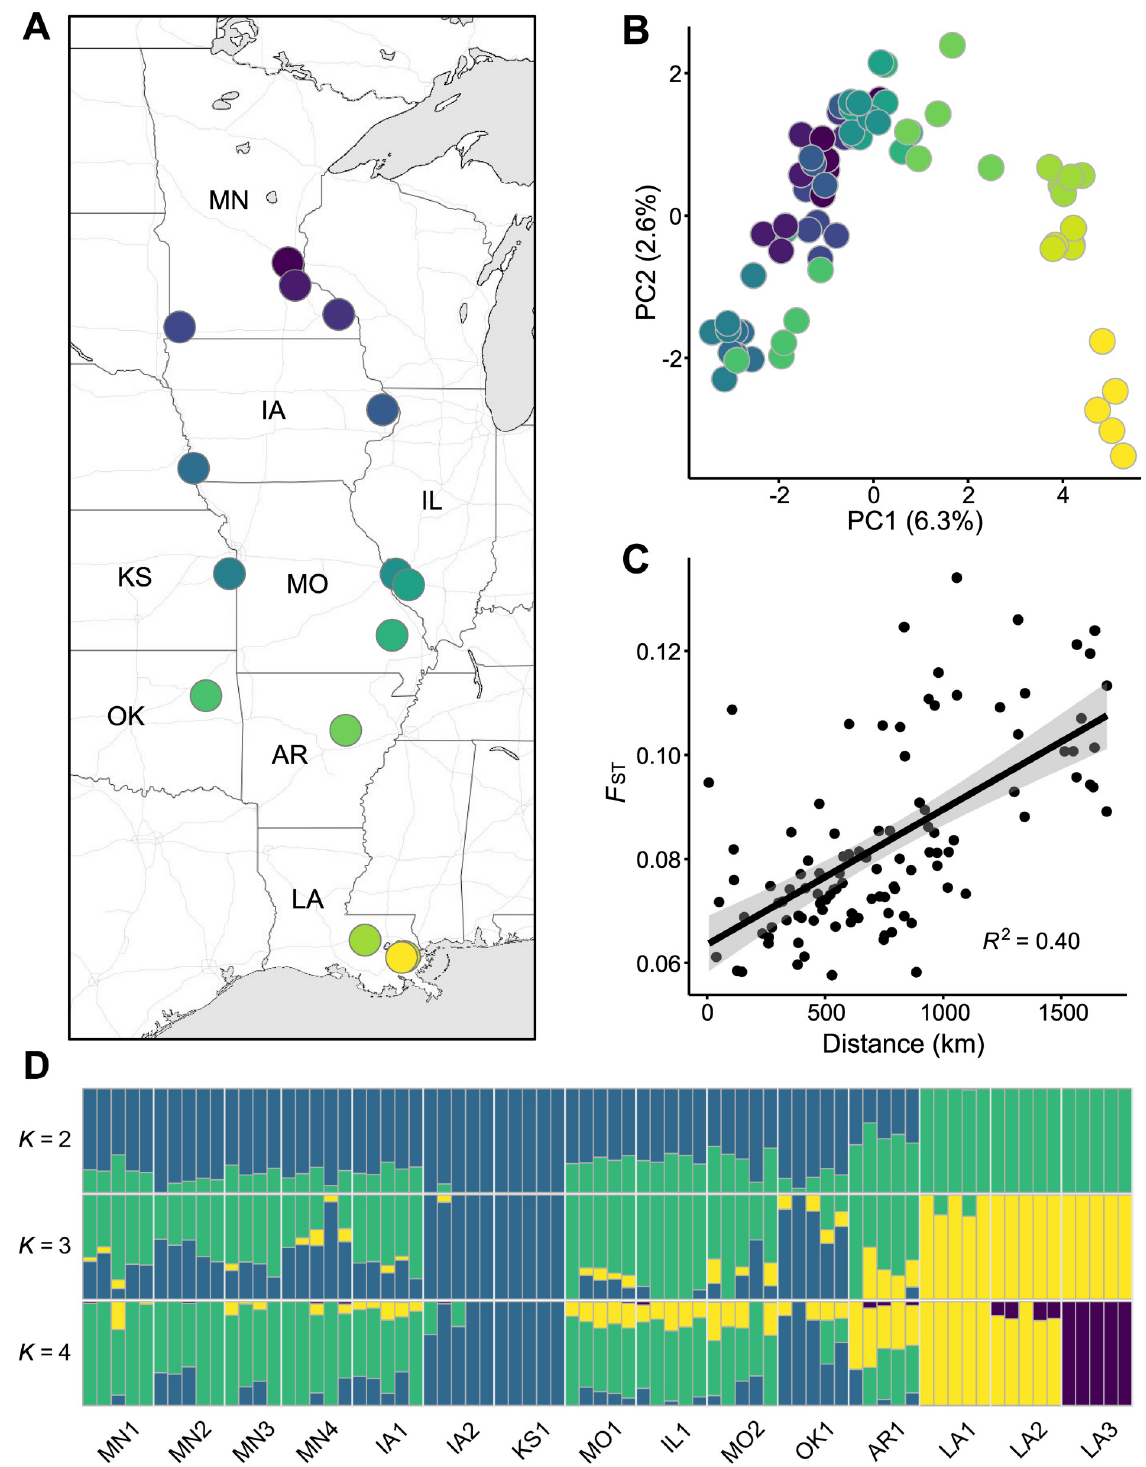
Fig 1. Population structure in A . artemisiifolia . A : Map showing locations of the populations. Map tiles by Stamen Design, under CC BY 3.0. B : Genetic variation along the first two axes of a principal components analysis (PCA). Variation explained by the PCs is shown in brackets. C : The increase of genetic distance ( F ST ) as a function of geographical distance between the populations. D : Estimated admixture proportions for three different numbers of ancestral populations ( K ).